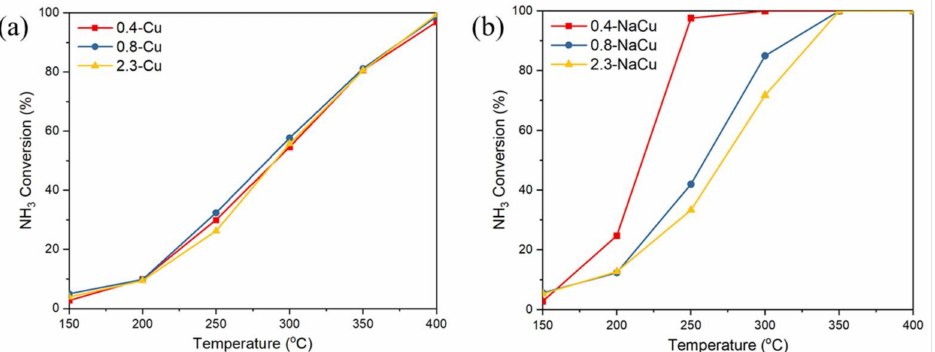
Figure 3. NH 3 oxidation activity of Cu/SSZ-13 ( a ) before and ( b ) after Na poisoning. The gas feed contains 500 ppm NH 3 , 10% O 2 and balanced N 2 . The gas hourly space velocity (GHSV) is 72,000 h − 1